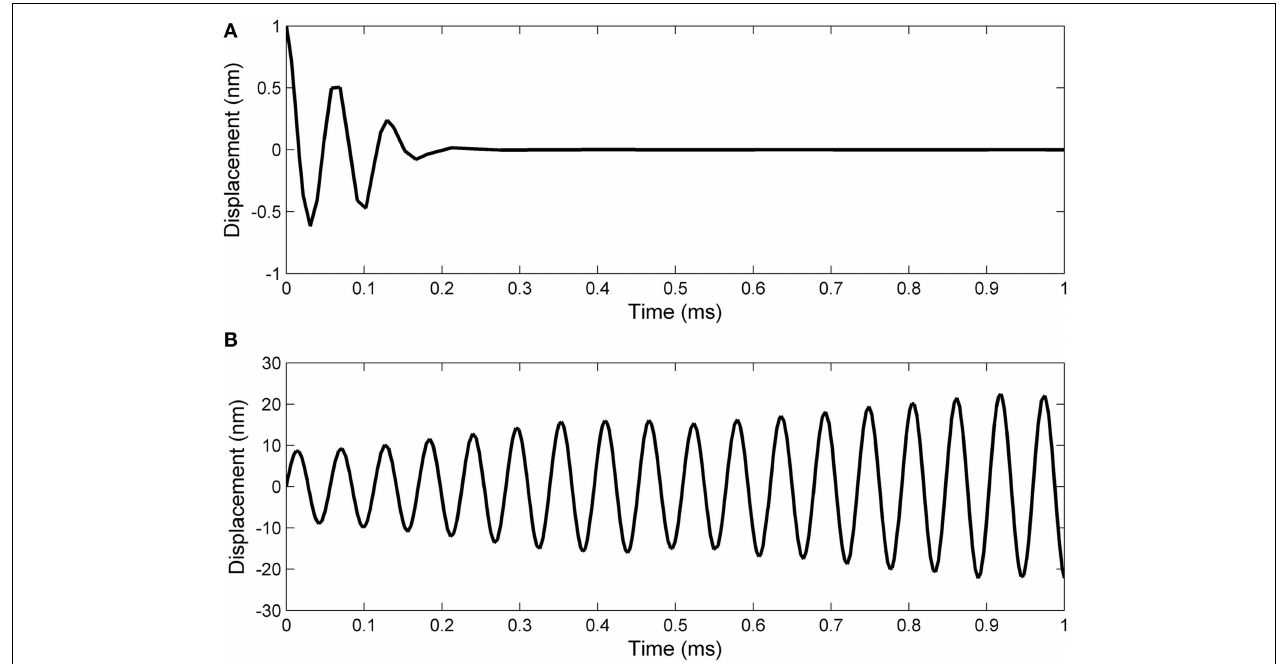
FIGURE 4 | A closer look at the displacement evolution during 1ms in the following cases: (A) initial displacement of 1nm and initial speed of 10nm/ms; (B) zero initial displacement and initial speed of 1nm/ µ